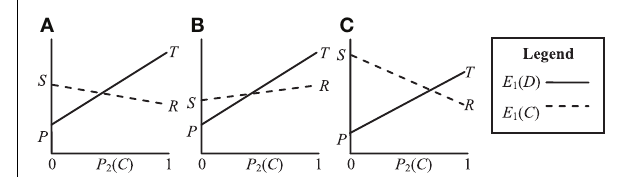
FIGURE 2 | Visualization of the payoff structures for (A) Leader T > S > R > P , (B) Chicken T > R > S > P and (C) Battle of the Sexes S > T > R > P